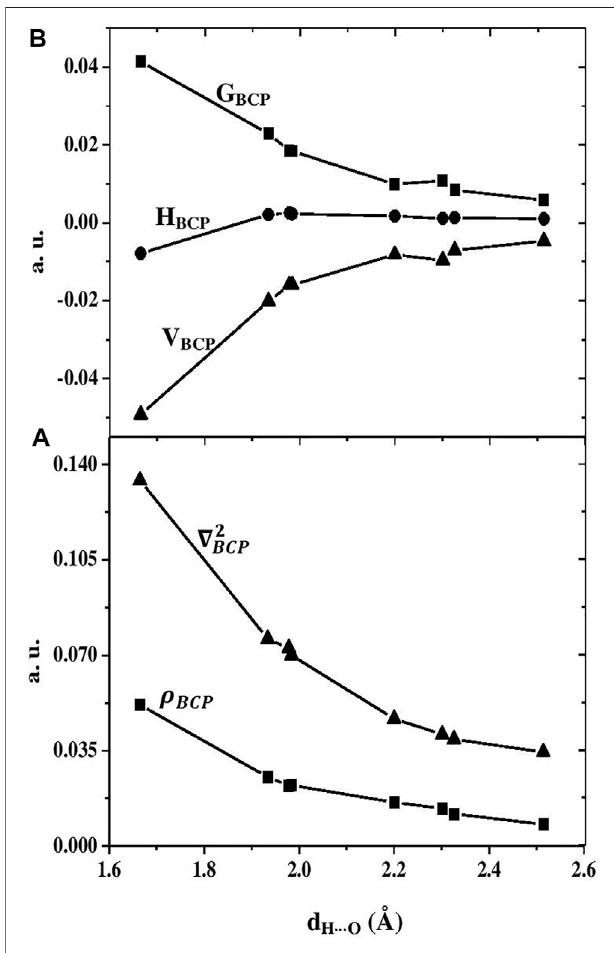
FIGURE 3 | (A) Variation of the electron density ( ρ BCP in a. u. rectangle symbol) and its Laplacian, ( ∇ 2 ρ BCP in a. u., triangle symbol) of the hydrogen bonds formed in the PA-(H 2 O) 4 versus their H ··· O lengths, d H ··· O in Å. (B) Hamiltoniankineticenergy(H BCP ina.u.,circlesymbol),thekineticenergy density (G BCP in a. u., rectangular symbol), and the potential energy density (V BCP in a. u., triangle symbol) at bond critical points in the PA-(H 2 O) 4 as a function of the hydrogen bond lengths, d H ··· O in Å.